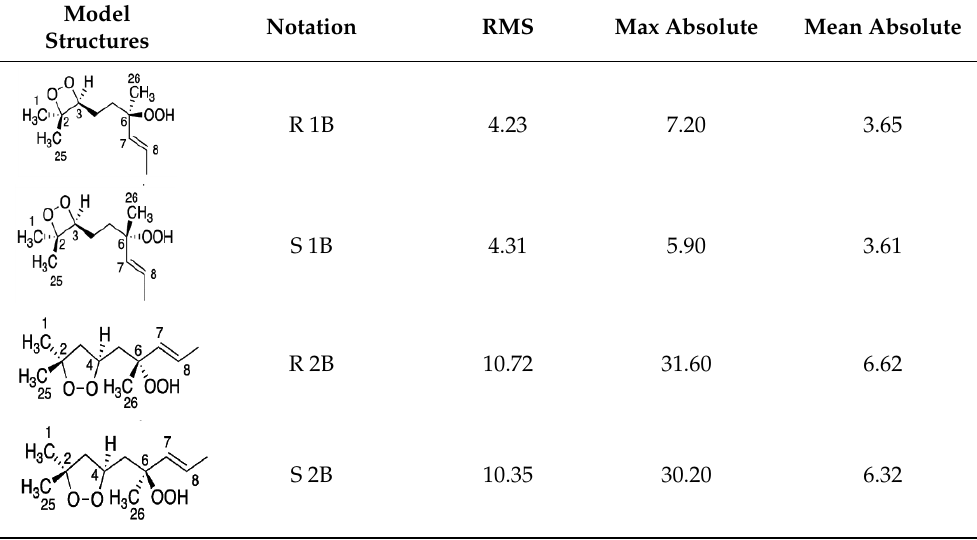
Figure 34. Signal assignment of hydroperoxides with the combined use of 1D NOE ( ) and 1D TOCSY ( ) . Figure 47. Schematic presentation of the combination of 1 H- 13 C HMBC ( ) and selective 1D TOCSY correlations ( ) which were observed in the case of the 9- cis , 12- cis , 14- trans -16-OOH hydroperoxide ( A ), and the 9- cis , 11- trans - 16-OOH endo -hydroperoxide ( B ) of the methyl linolenate primary oxidation products. Model Structures